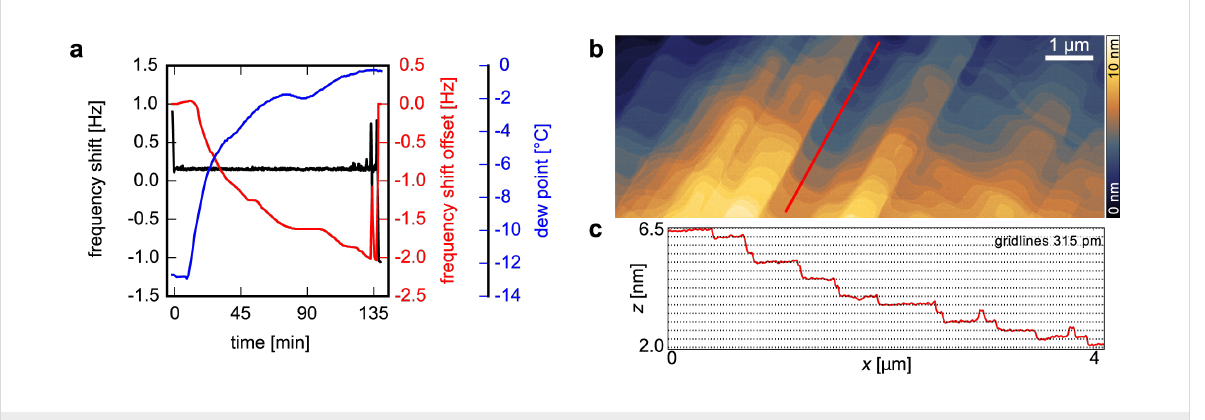
Figure 3: Application of the slow feedback control. a) Evolution of frequency shift Δ f (black), frequency shift offset Δ f offset (red), and dew point (blue) over 140 min. b) Large scale topography of a KBr surface and c) corresponding height profile along the red line in b). The step height is 315 pm. Scan parameters: A = 1.1 nm, Δ f = +0.15 Hz, scan speed 10 μ